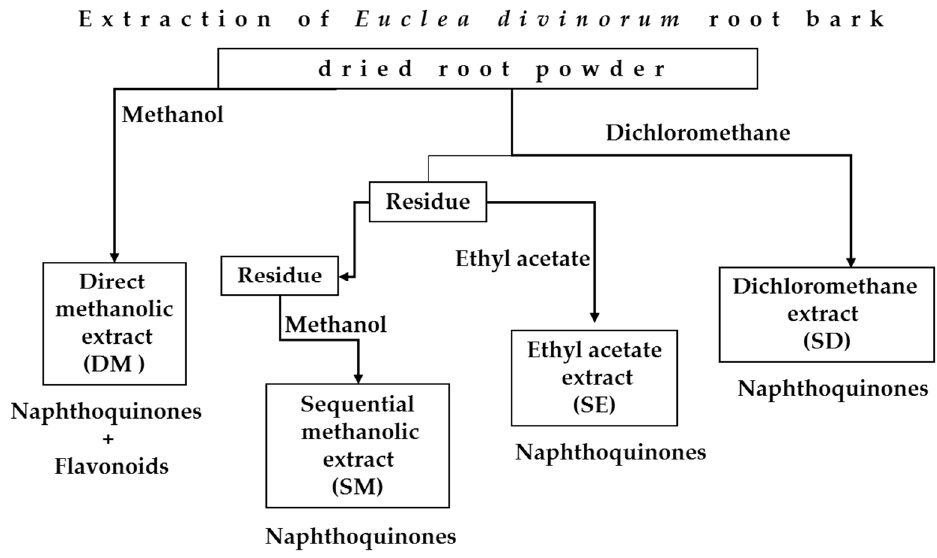
Figure 1. The extraction process of Euclea divinorum root bark.